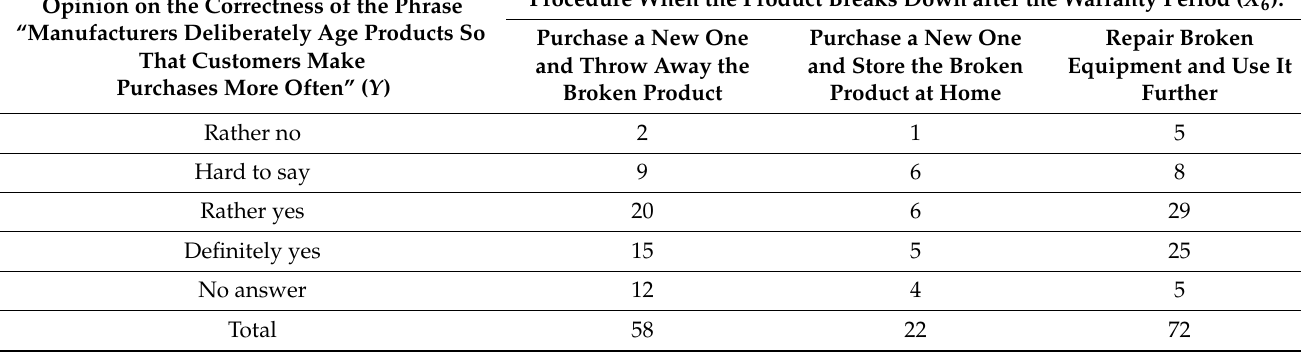
Table 3. Opinions of respondents on the deliberate aging of products depending on the expected life of the equipment used. Estimated Length of the Functioning of the Used Equipment Compared to the Assumed Time on the Day of Purchase ( X 4 ) Definitely shorter than T * - - - 1 Rather shorter than T Neither longer nor shorter than T - Rather longer than T Definitely longer than T